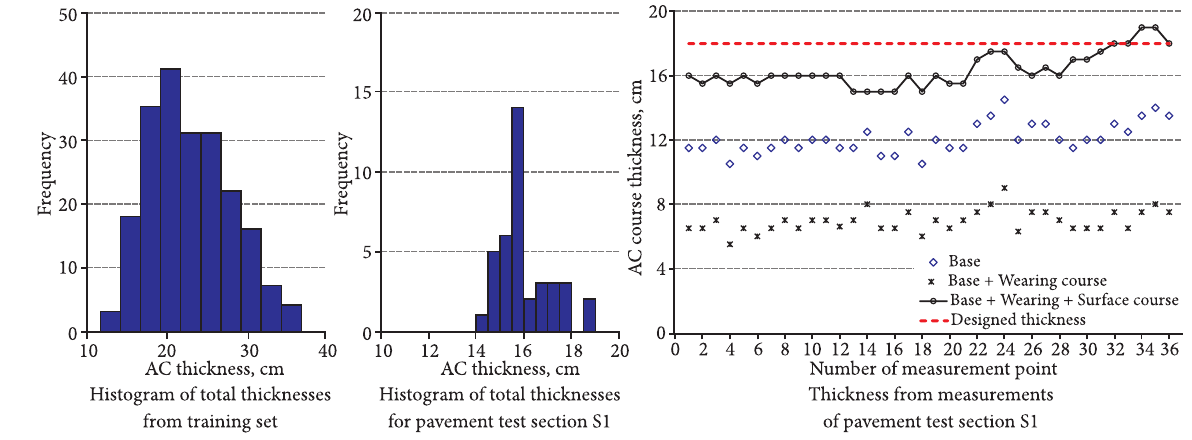
Fig. 3. View of the Section 1